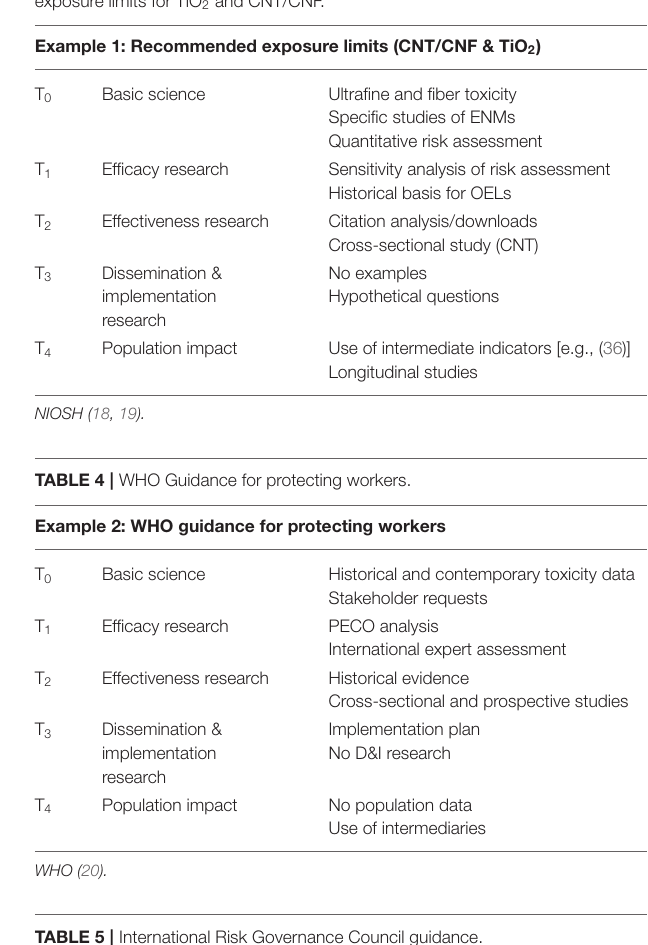
TABLE 5 | International Risk Governance Council